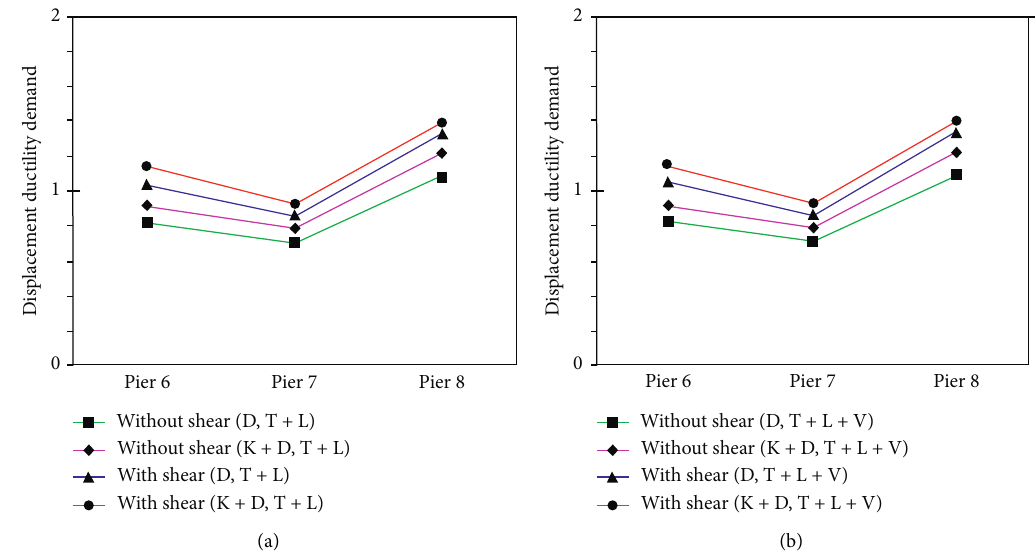
Figure 5: Comparison of ductility demand under D and K+D earthquakes. (a) Under biaxial input ground motions. (b) Under triaxial input ground motions.